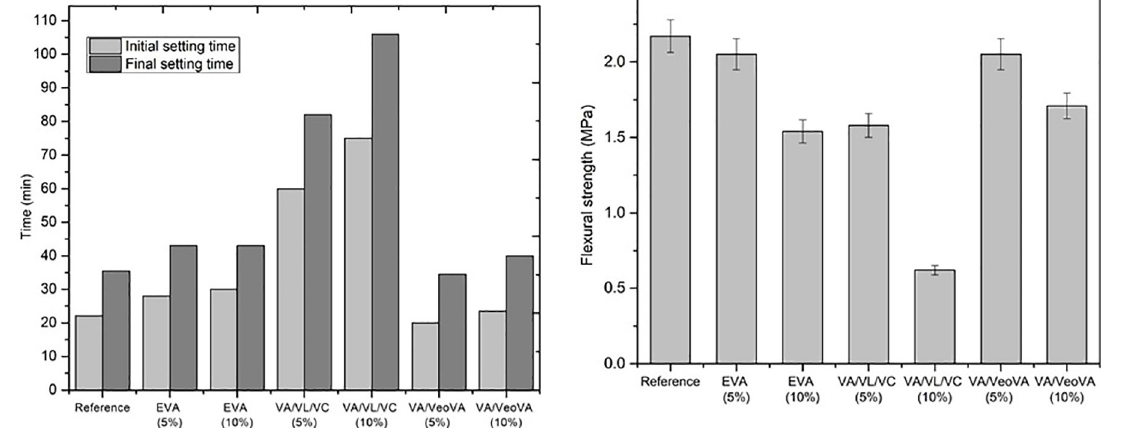
Figure 1. Initial and final setting time of modified gypsum. Figure 2. Flexural strength of modified